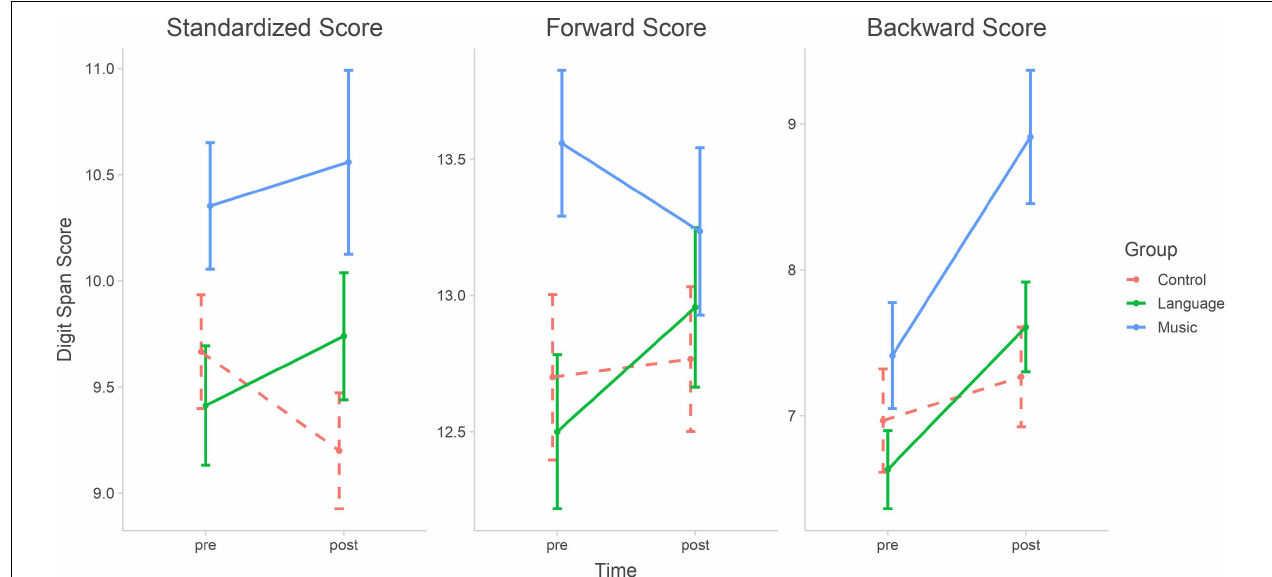
FIGURE 1 | Comparisons of digit span scores between groups (Mean and SE). Music group gained significant improvement compared with Language and Control group in digit span backward scores. However, no significant interaction between Group and Time was found in the digit span forward scores or digit span standardized